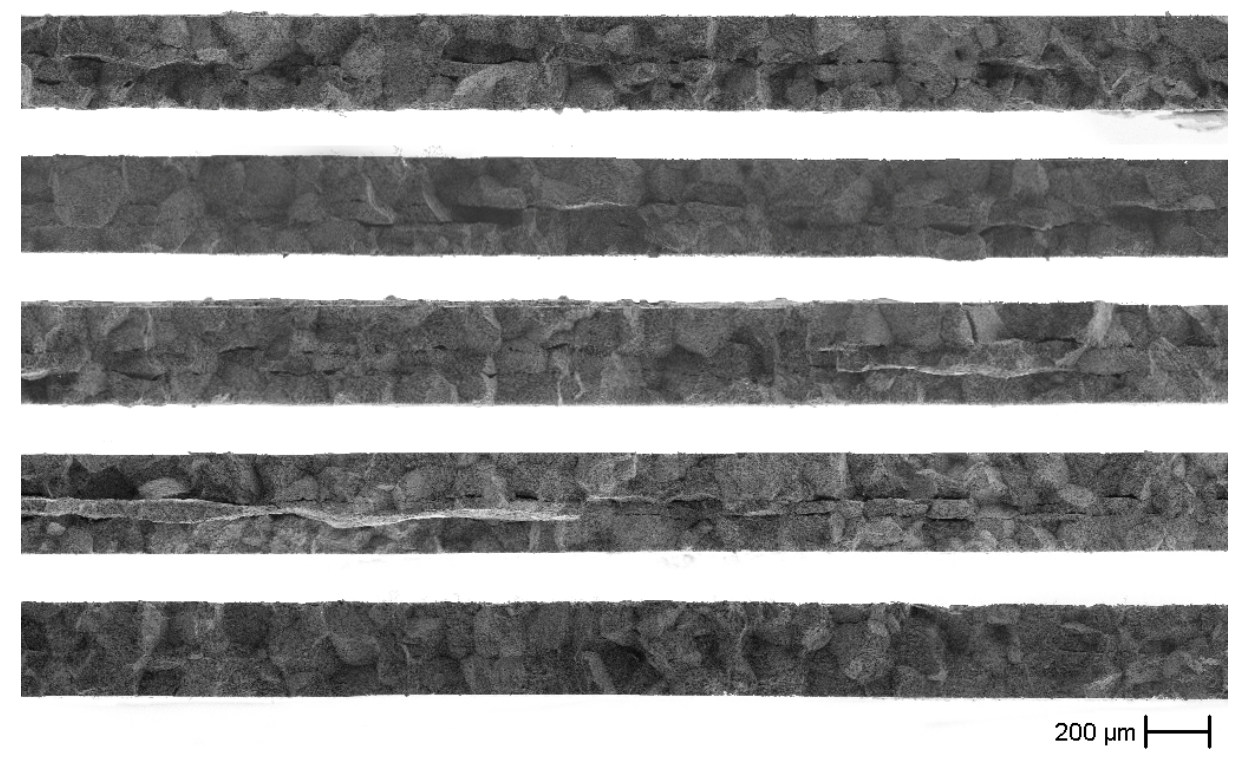
Figure 10. Fracture surfaces after tensile tests, from top to bottom: specimens 1–5 (SEM). An intercrystalline fracture path is clearly visible. In the middle of specimens 1 to 4 damages perpendicular to the fracture surface are visible.